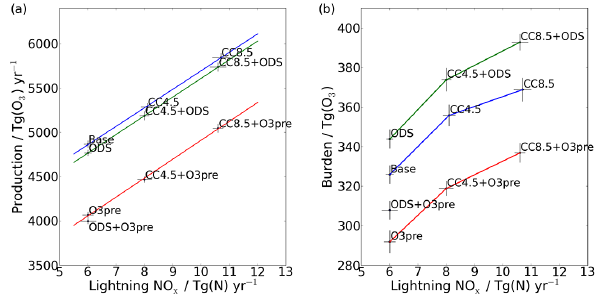
Figure 2. Correlation between (a) P (O x ) and LNO x and (b) tropo- spheric ozone burden and LNO x . Linear fits in (a) and connecting lines in (b) are drawn between runs which differ only in their cli- mate states. Error bars indicate ± 1 standard